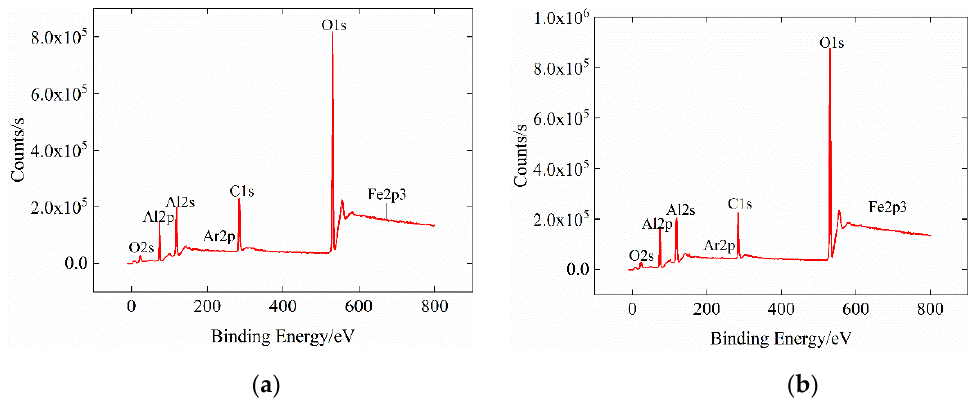
Figure 8. XPS spectrum of the Fe co-deposition irradiated samples surface. ( a ) XPS spectrum of the near target region; ( b ) XPS spectrum of the far target region.